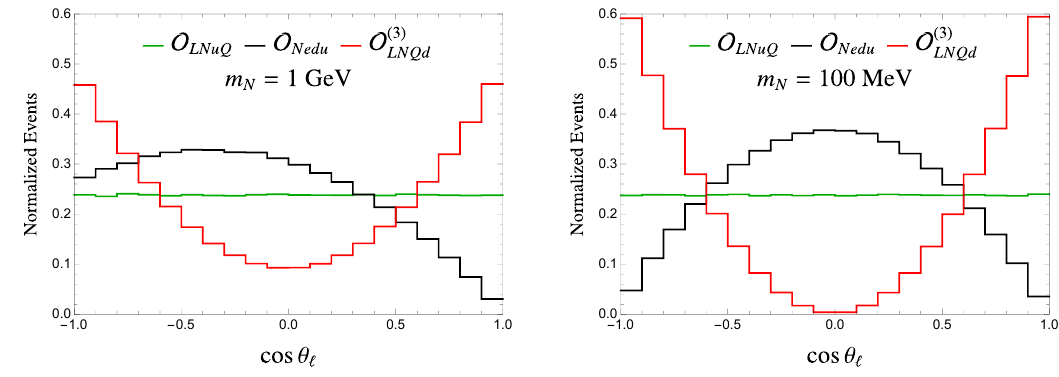
Figure 1 . cos θ ‘ distributions for m N = 1 GeV (left panel) and 100 MeV (right panel) from ¯ B 0 → D + ‘ − ¯ N with different production operators in SMNEFT. Here θ ‘ is the angle between the charged lepton momentum in the ‘ ¯ N rest frame and the D momentum in the ¯ B rest